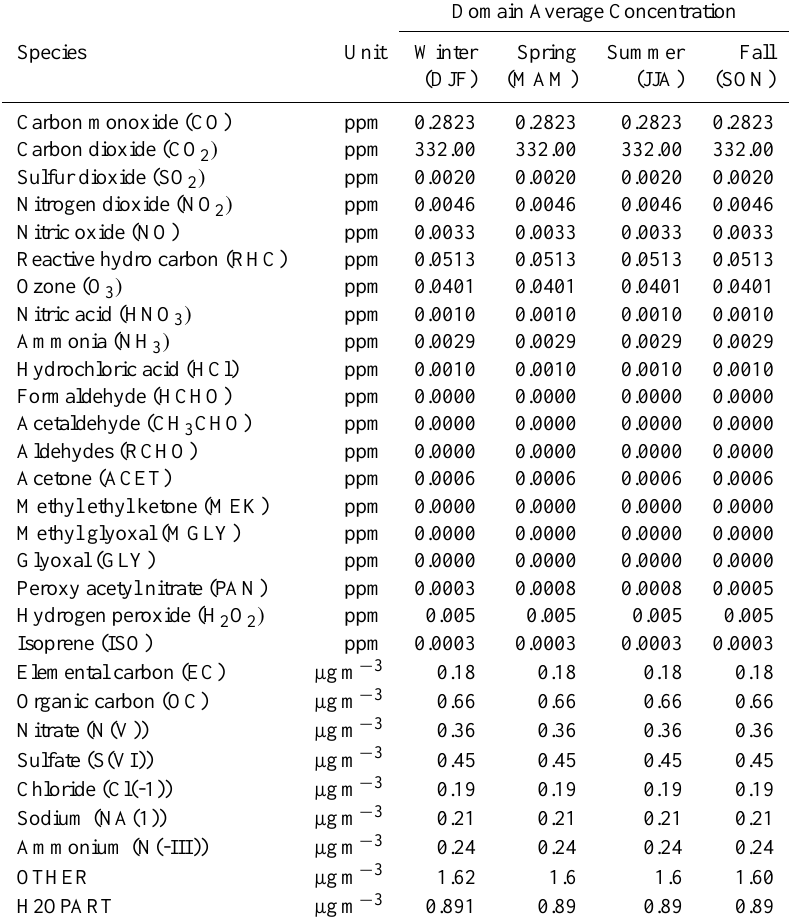
Table 1. Domain-averaged initial concentrations of major model gas and particle species at the